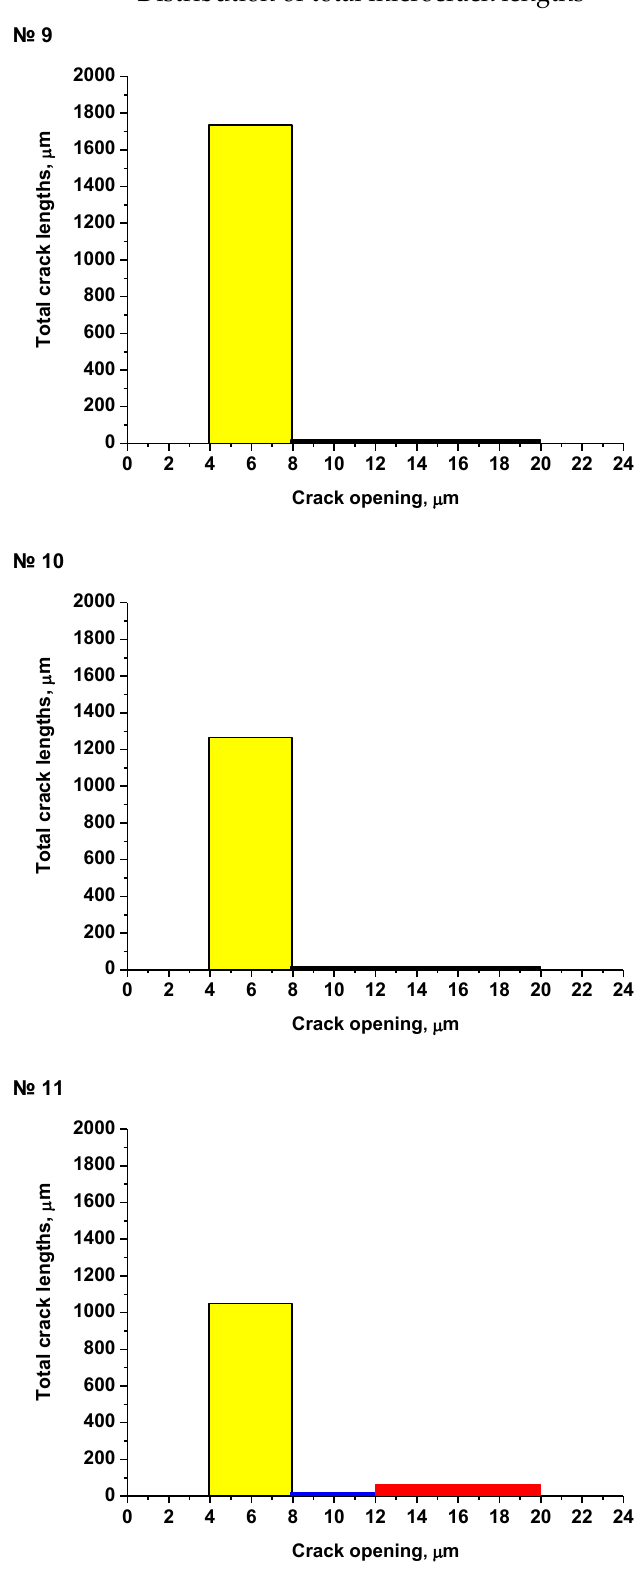
Figure 22. Total microcracks lengths with different microcrack opening values for specimens № 9– №11 irradiated at 550 °C after autoclave tests and additional loading.